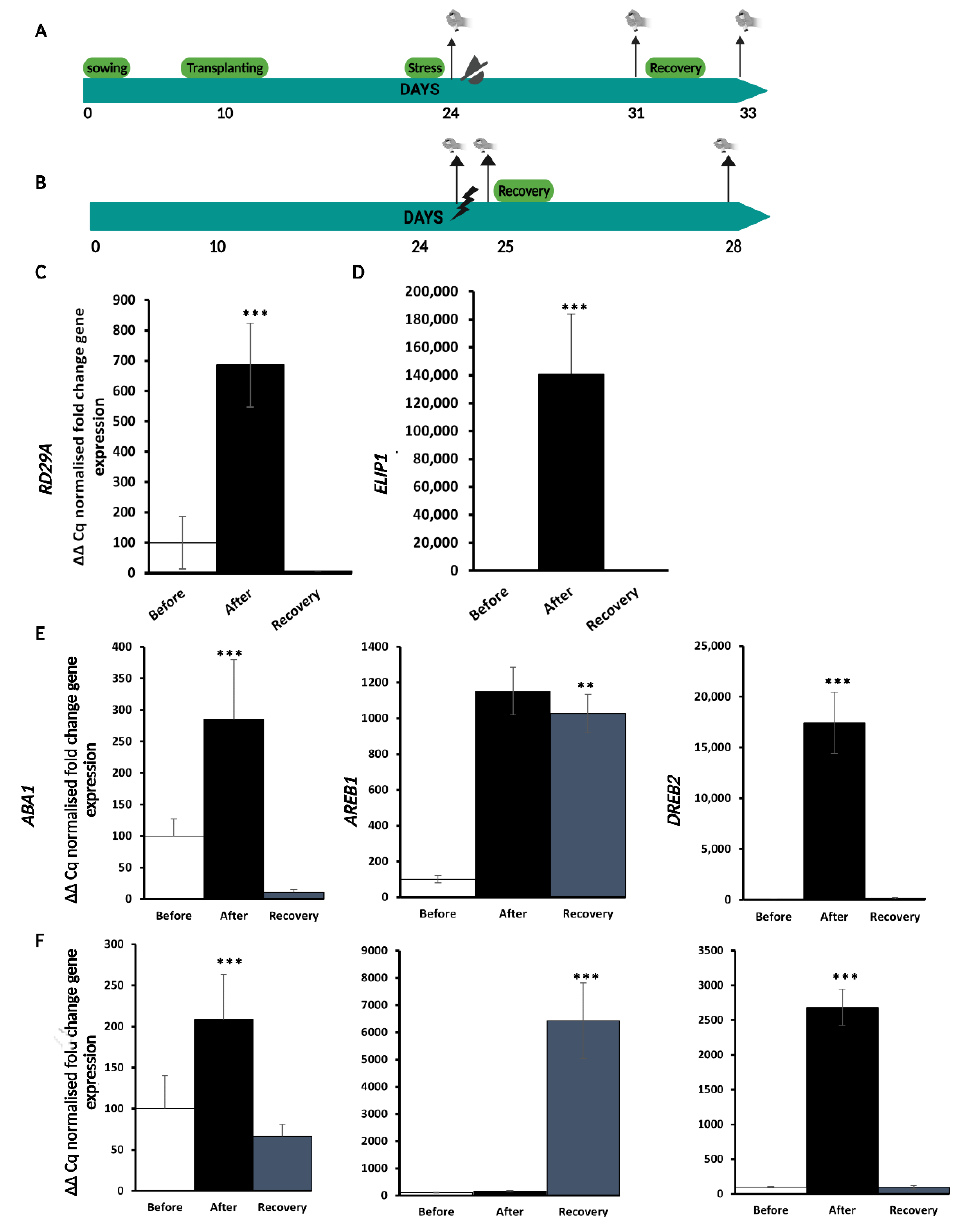
Figure 1. D and HL stress experimental scheme and marker gene expression analysis. ( A ) Experimental scheme for single D stress response and recovery. ( B ) Experimental scheme for single HL stress response and recovery. ( C ) The relative fold change gene expression of RD29A at three time points (before = prior to D treatment 24 d, after = immediately after D 31 d, and recovery = 3 days after D treatment ended). ( D ) The relative fold change gene expression of ELIP1 at three time points (before = prior to HL treatment, after = immediately after HL, and recovery = 3 days after HL treatment ended). Relative expression of ABA genes from single D stress ( E ) or HL ( F ) stress experiment. Data are a representation of one biological replicate with SD values. The two remaining biological replicates are shown in Supplementary Figures S1–S3. Statistical significance analyzed by t- test, ** p < 0.005, *** p < 0.001.